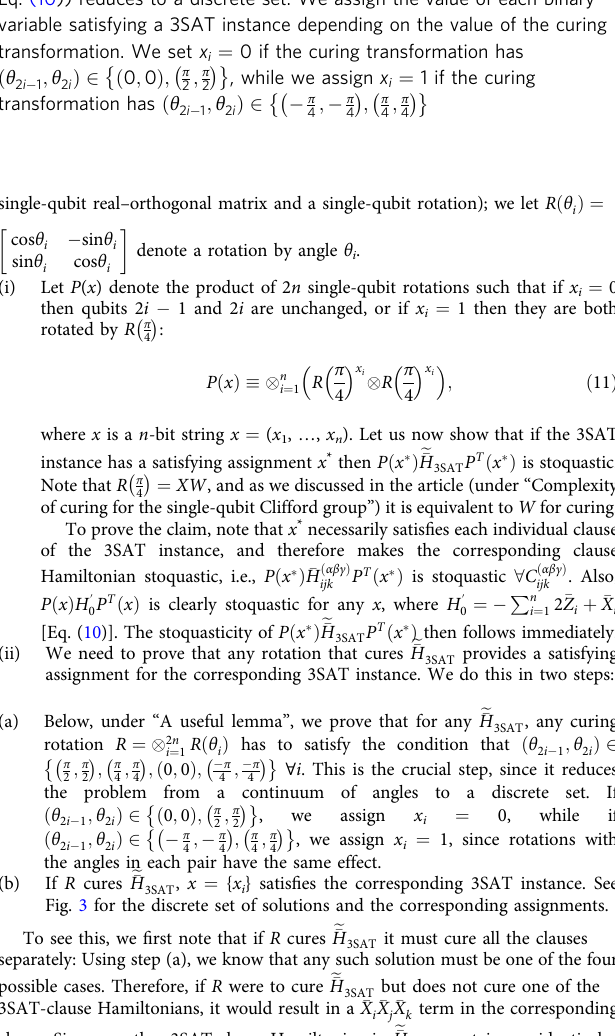
e (cid:2) H (introduced in 3SAT